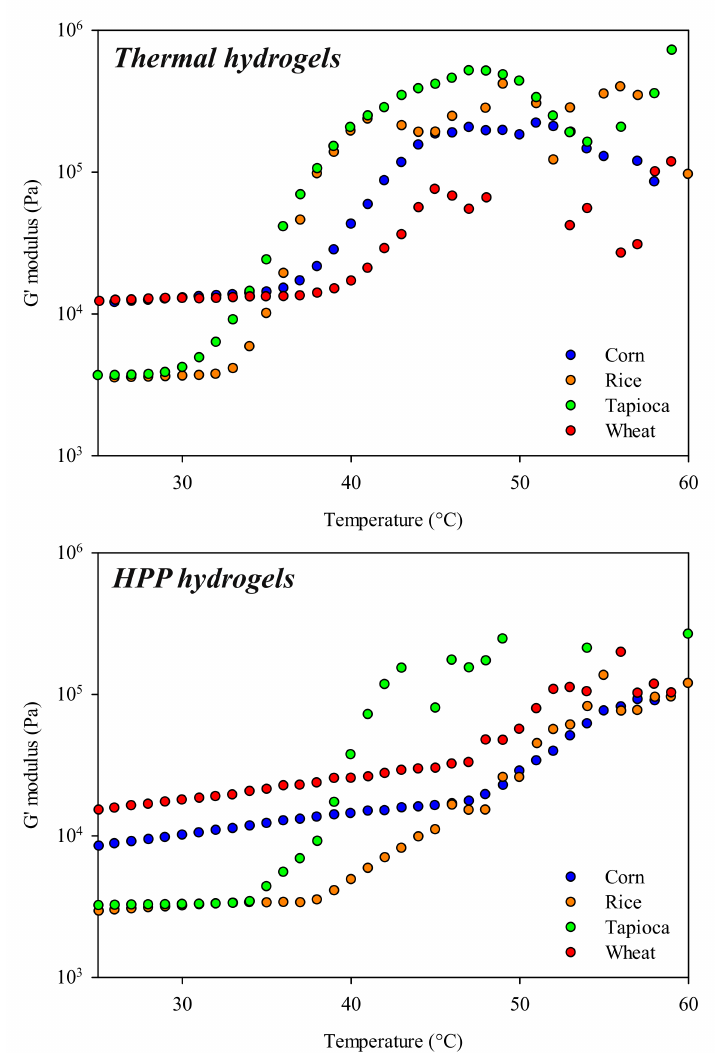
Figure 5. The influence of temperature stress on the elastic response (G (cid:48) modulus) of starch-based hydrogels immediately after HPP treatments and thermal